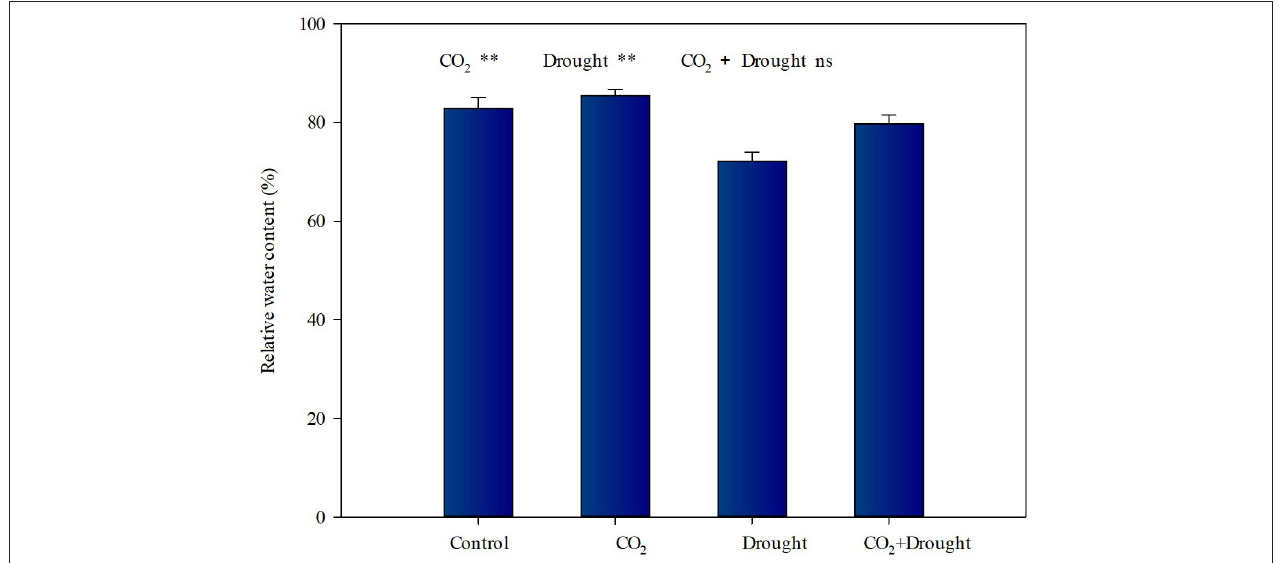
FIGURE 1 | Relative water content of Triticum aestivum grown under elevated CO 2 and drought conditions. Each value shown represents the mean ( ± SE) of three replicates. P values are provided for two-way ANOVA on the effects of elevated CO 2 and drought treatments on relative water content. Significant differences: * P < 0.05; ** P < 0.01; ns, P >